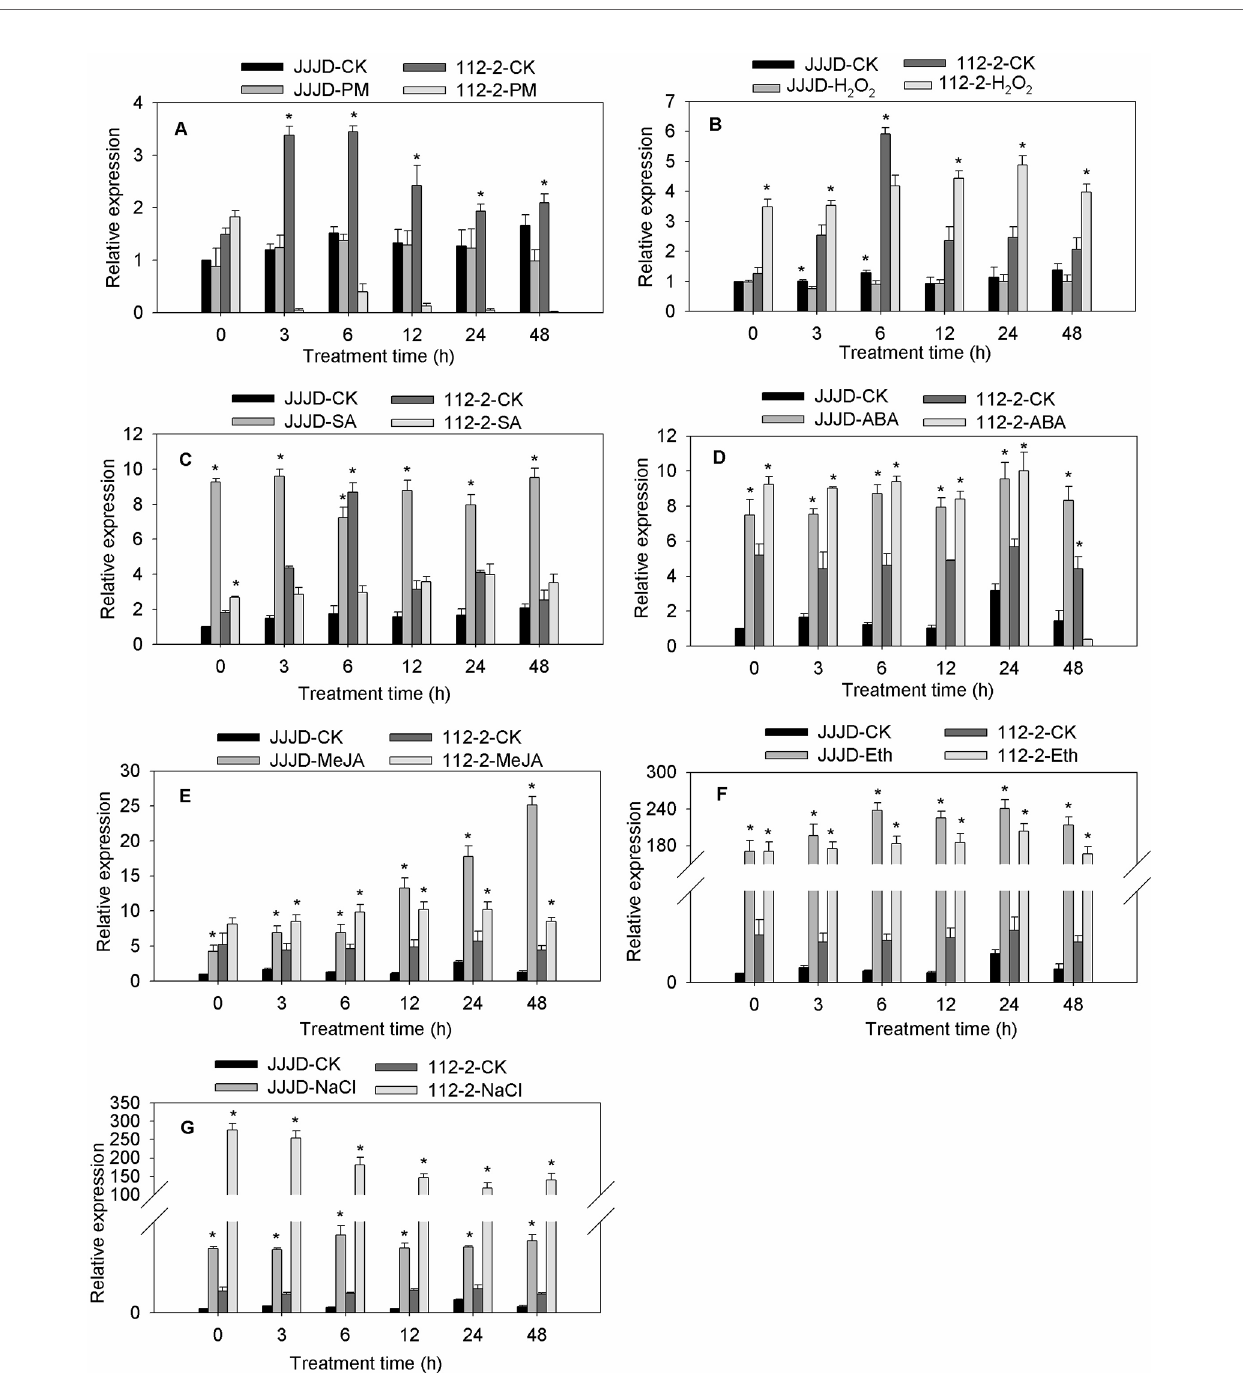
FIGURE 2 | CmbHLH87 expression in response to powdery mildew and exogenous treatments. The pumpkin seedlings were sprayed with a spore suspension (A) , exogenous hydrogen peroxide (H 2 O 2) (B) , salicylic acid (SA) (C) , abscisic acid (ABA) (D) , methyl jasmonate (MeJA) (E) , ethephon (Eth) (F) , and NaCl (G) . The b -actin gene was used as an internal reference for qRT-PCR. The transcript level of CmbHLH87 in the cultivar ‘ JJJD ’ at 0 h was used as control (quantities of calibrator) and assumed as 1. The values are the means ± SEs of three biological replicates. Data between treatments (112-2-treatment vs. 112-2-CK and JJJD-treatment vs. JJJD-CK) were analyzed by one-way ANOVA, and *denotes statistical signi fi cance at p <